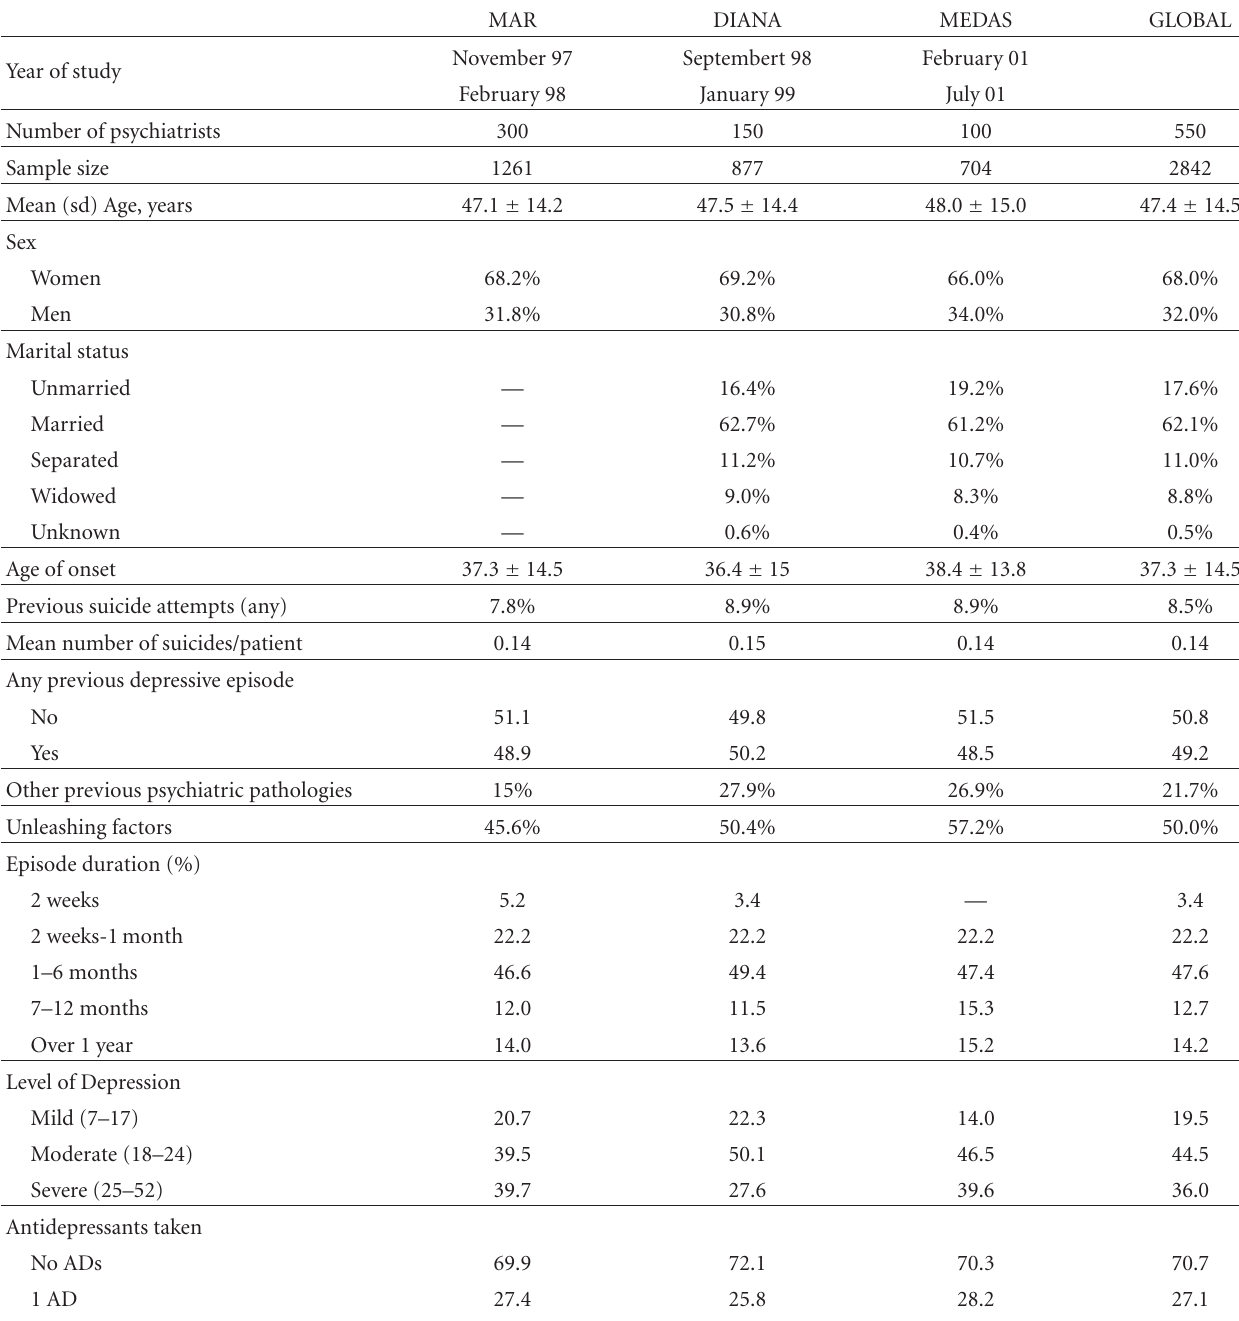
Table 3: Characteristics of each database and the global sample.